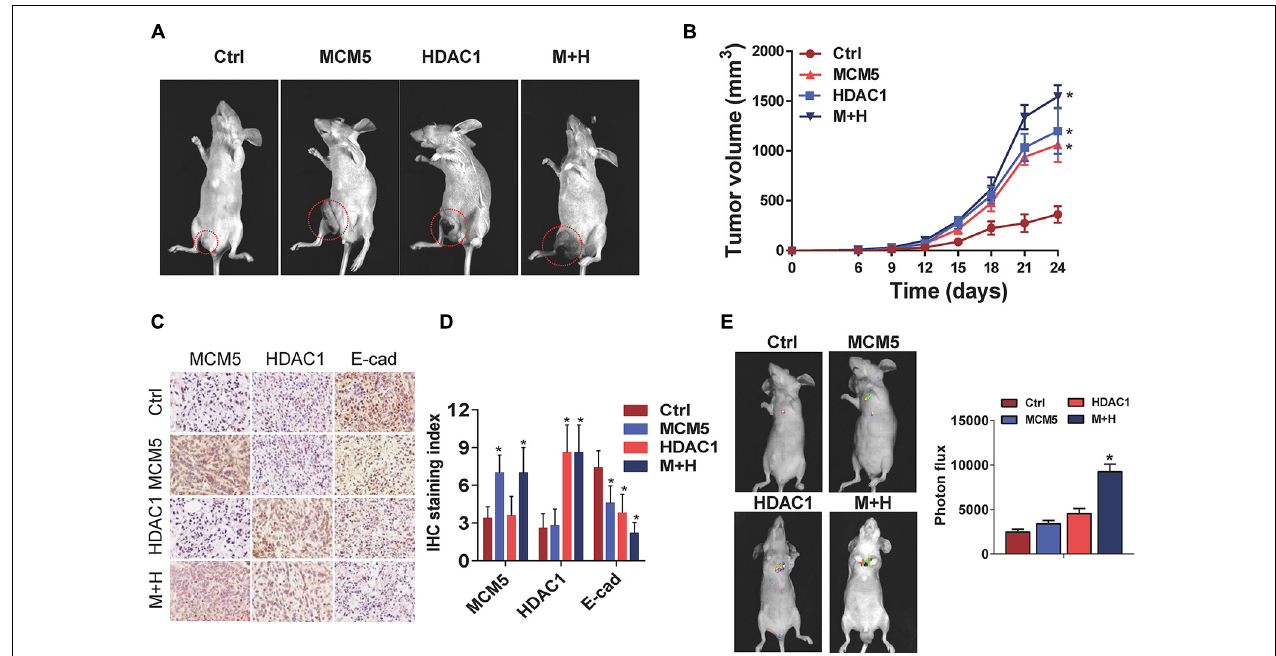
FIGURE 5 | MCM5/HDAC1 complex promoted tumor proliferation and lung cancer metastasis. After H1975 cells overexpressing MCM5 and HDAC1 were inoculated into nude mice, the harvested tumors were used to detect the expression of MCM5, HDAC1, and E-cadherin by IHC test in solid tumors. (A) Images of tumors under different treatments. (B) Evaluation of tumor growth at different times. (C,D) Detection of MCM5, HDAC1, and E-cadherin expressions in tumors through immunohistochemistry. (E) Representative images of in vivo bioluminescence imaging. * P < 0.05.